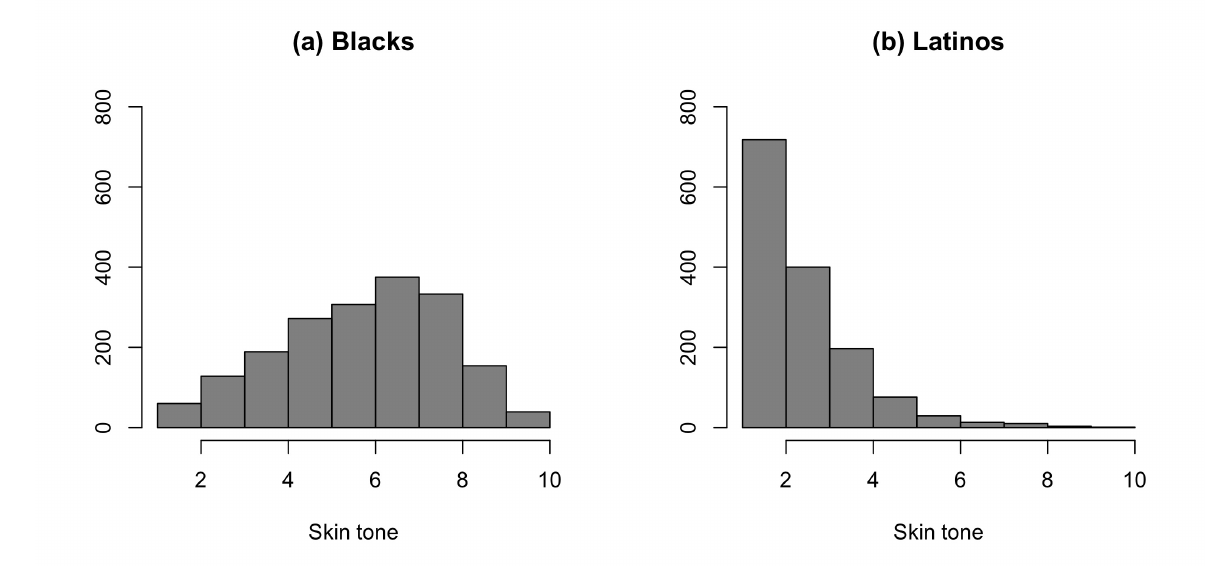
Figure 2: Skin tone distribution for Black and Latino respondents (nonimputed